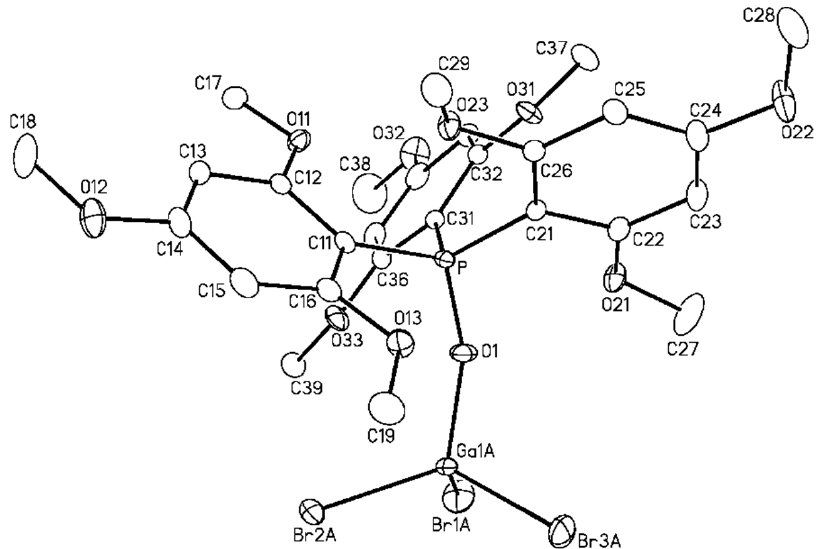
Figure 2. Perspective view of the [{tris(2,4,6-trimethoxyphenyl)phosphine oxide}GaBr 3 ] (2) molecule, showing the atom labeling scheme. The 90% conformer of {Ga 1 A(Br 1 ABr 2 ABr 3 A)} present in the crystal structure is shown here; see Figure 4 for the 10% conformer.